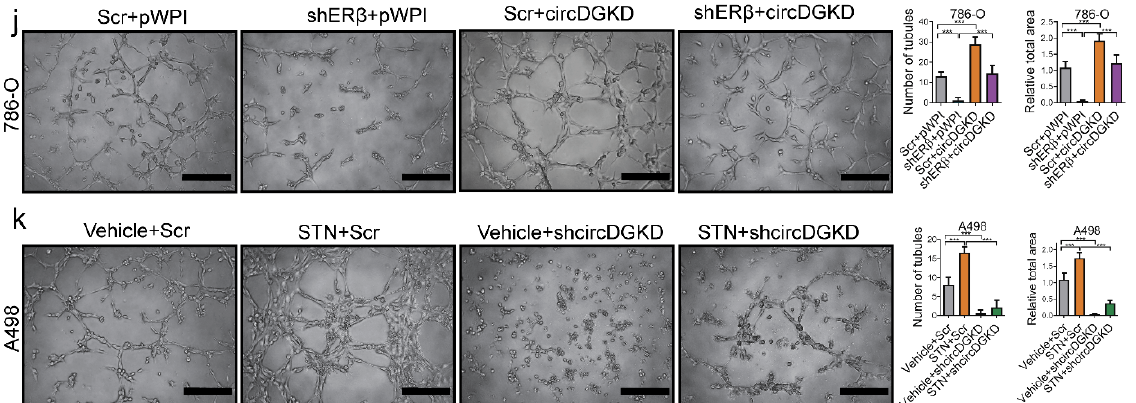
Figure 4. The circDGKD mediates the ER β -regulated VE-cadherin and VM formation in RCC. ( a ) Schematic diagram of constructing shRNA plasmid of circDGKD targeting the junction region, and wild-type (Wt)/MRE-125 mutant (Mut) circDGKD overexpression plasmid by adding Alu element on the flank. ( b ) Knockdown of circDGKD (shcircDGKD) decreased VE-cadherin level in 786-O cells. ( c ) Overexpression of circDGKD increased VE-cadherin in A498 cells. ( d ) Knockdown of circDGKD and overexpression of miR-125b-5p both decreased psiCHECK2-CDH5 luciferase activity, whereas knockdown of circDGKD, on the basis of overexpressed miR-125b-5p, did not further decrease the luciferase activity. ( e ) Overexpression of Wt circDGKD, but not the circDGKD with MRE-125 binding site Mut, significantly increased the luciferase activity of psiCHECK2-CDH5, in the absence or presence of miR-125. ( f – k ) Interruption assays of ER β and circDGKD regulation of VE- cadherin and VM formation. Overexpression of circDGKD restored shER β -decreased VE-cadherin in both mRNA ( f ) and protein ( g ), and rescued the shER β -impaired VM formation in 786-O cells ( j ). Sunitinib (STN) significantly increased VE-cadherin mRNA ( h ) and protein level ( i ) in A498 cells, and boosted the VM formation capacity ( k ), whereas this effect was interrupted by shcircDGKD. Scale bar, 20 µ m. For ( j , k ), quantitations are at the right. Data are presented as mean ± SEM. ** p < 0.01, *** p < 0.001. NS: not statistically